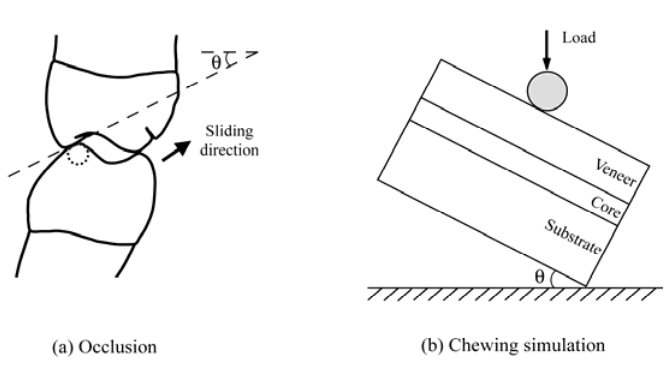
Figure 3. The schematic shows (a) posterior tooth contact in a chewing cycle as an eccentric contact of the mandibular buccal cusps with the inner inclines of the maxillary buccal cusps, followed by a sliding movement through centric occlusion, and then lifting off; (b) represents the sliding movement as a straight-line motion of a spherical indenter on the surface of a flat brittle layer (crown) supported by a complaint substrate (tooth dentin) with an inclination angle θ = 30 °